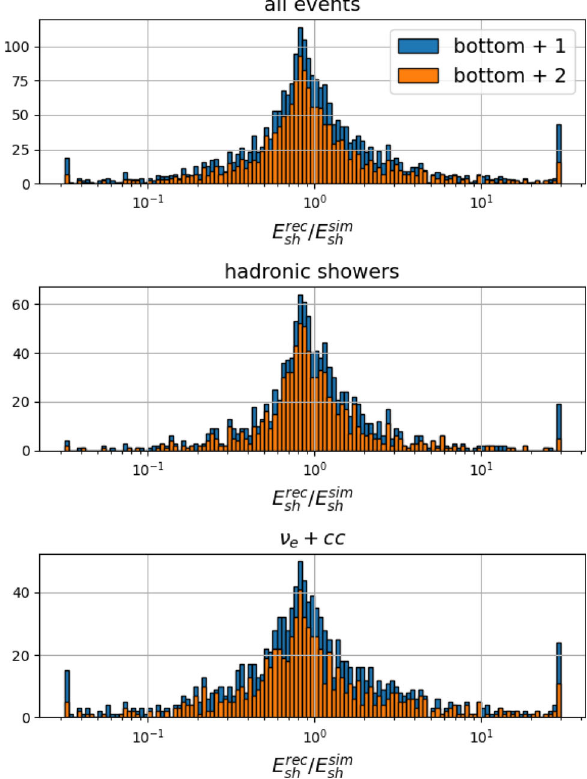
Fig. 18 Ratio between reconstructed and actual shower energy if a random time offset drawn from a normal distribution with σ t = 0 . 3 ns is applied to each channel. Shown are results of events where at least one of the channels at ∼ 100 m as well as at least one (blue) or at least two (orange) of the other channels on the power string detected a signal with SNR ≥ 2 . 5. The outermost bins are overflow bins